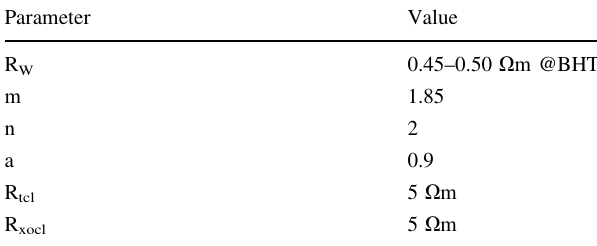
Table 2 Parameters used for determining water saturation